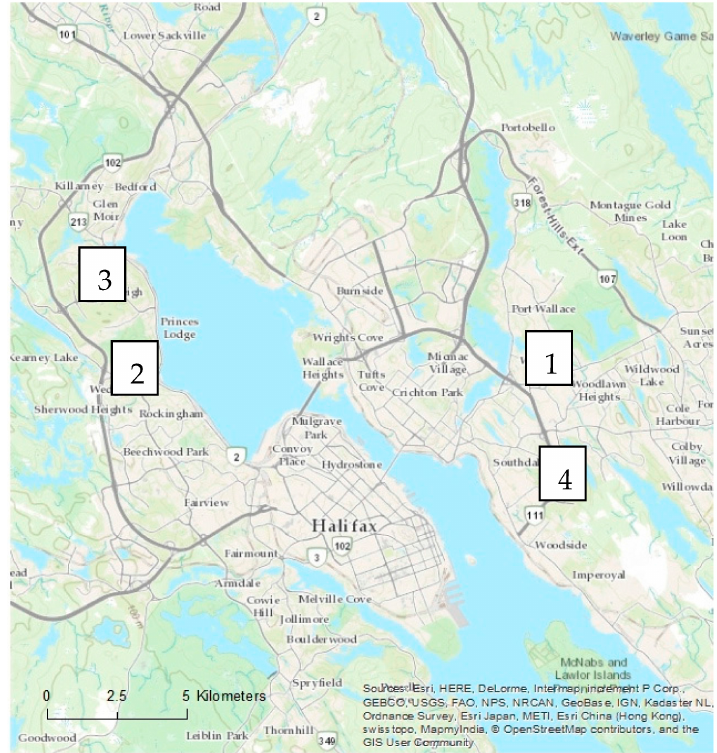
Figure A2. The neighbourhoods examined in Halifax: Tam O’Shanter ( 1 ); Birch Cove ( 2 ); Millview ( 3 ); and Russell Lake West ( 4 ).